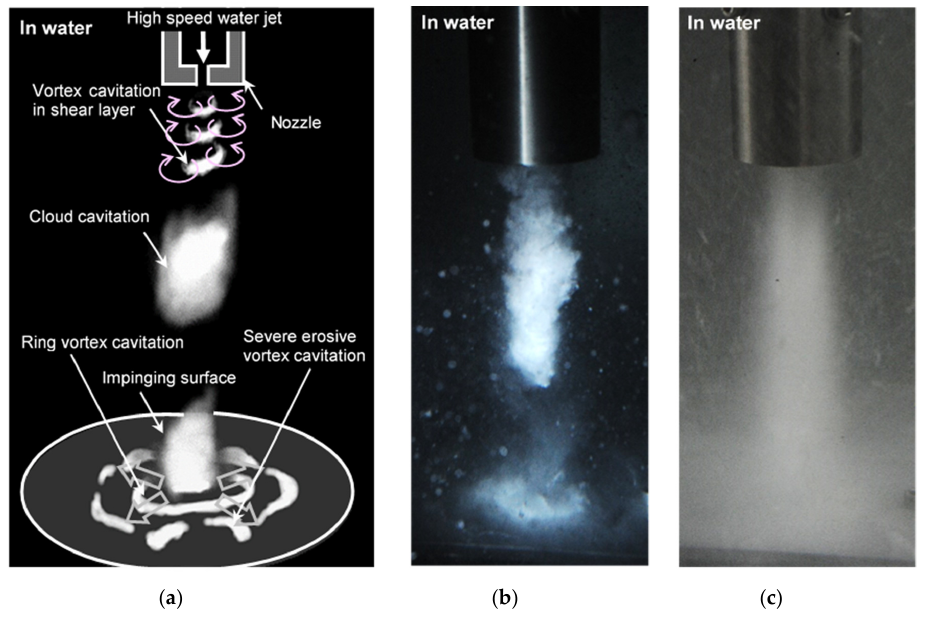
Figure 6. Aspects of submerged high-speed water jets, i.e., cavitating jet. ( a ) Schematic diagram; ( b ) Observation with flush lamp; ( c ) Observation with normal light.